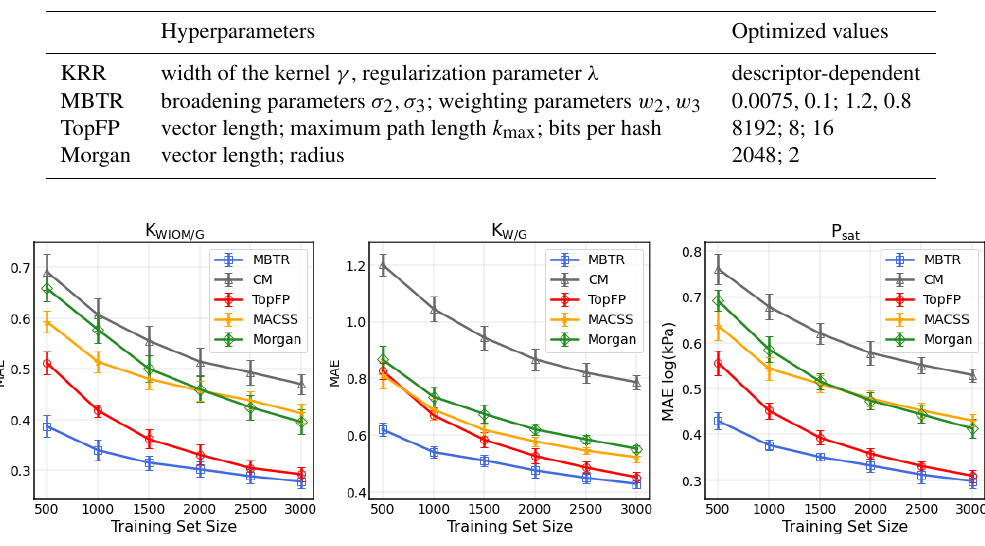
Figure 5. The learning curves for equilibrium partitioning coefficients K WIOM/G , K W/G , and saturation vapour pressure P sat for predictions made with all five